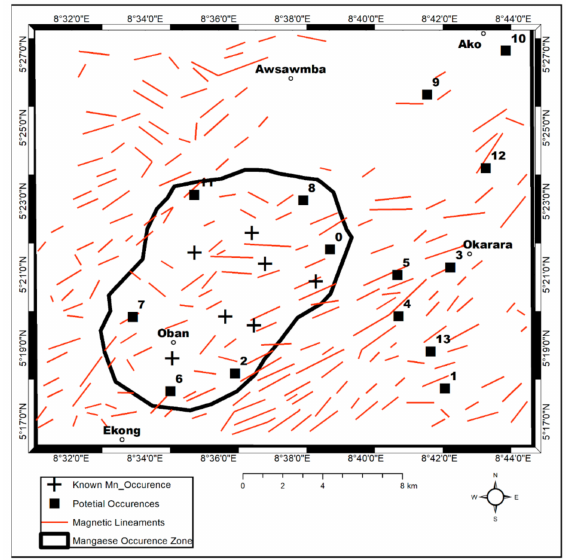
Figure 12. Magnetic lineament map of the study area.